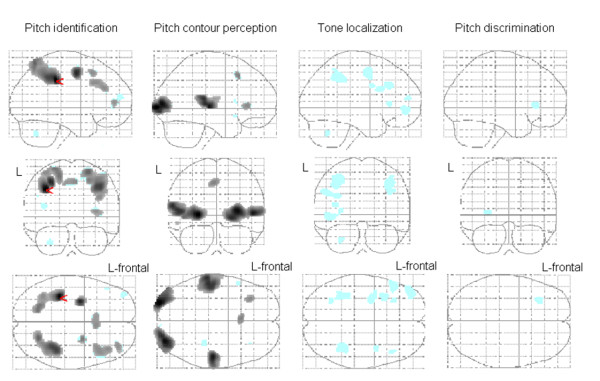
Signal changes compared to baseline on the normalized SPM-glass brain. The red arrow points to the only peak (x = -36, y = -34, z = 40) when the threshold p < .05 is FWE-corrected (see Table 1). Pitch identification activated the left intraparietal sulcus. Black regions show activation when the threshold p < .05 is FDR-corrected. In the azure regions emerged activation when the threshold is uncorrected p < .001. Table 1 displays a detailed description of regions activated after FWE- and FDR-correction. L = left hemisphere.